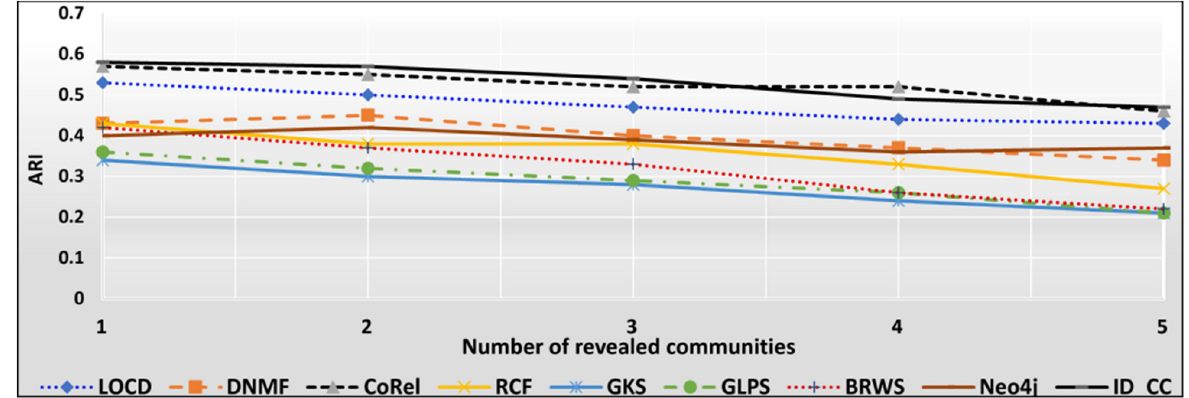
Fig 26. The accuracy of each method in terms of ARI for detecting the Friendster cross-communities resulted from the overlapping of m number of communities ( m = 1, 2, ... , 5).